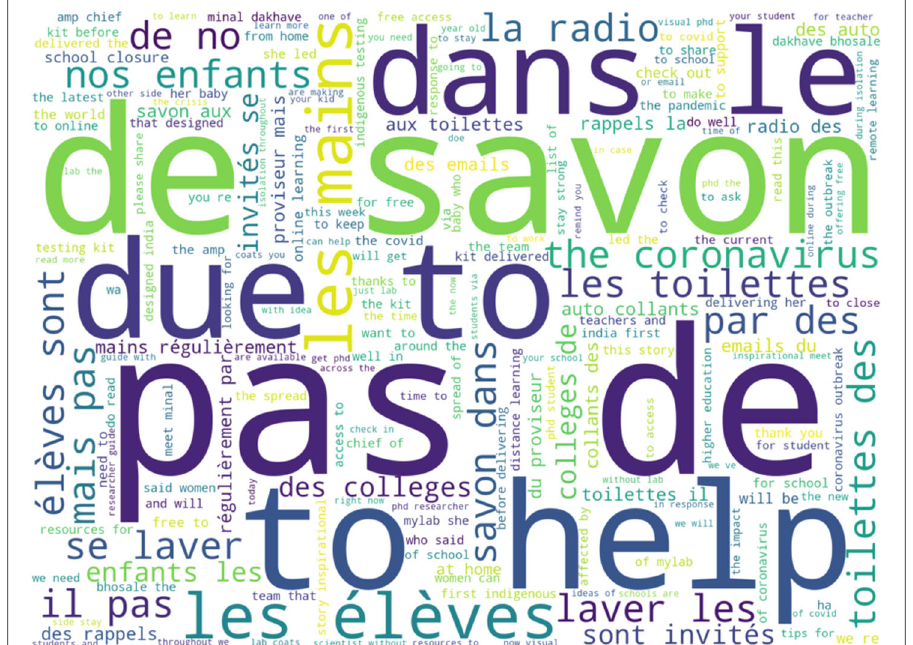
Fig. 13 Word map for commonly used words and phrases present in cluster 12 from period 2, which has education hashtags. The verbiage is a mix of primarily English and French and has many phrases relating